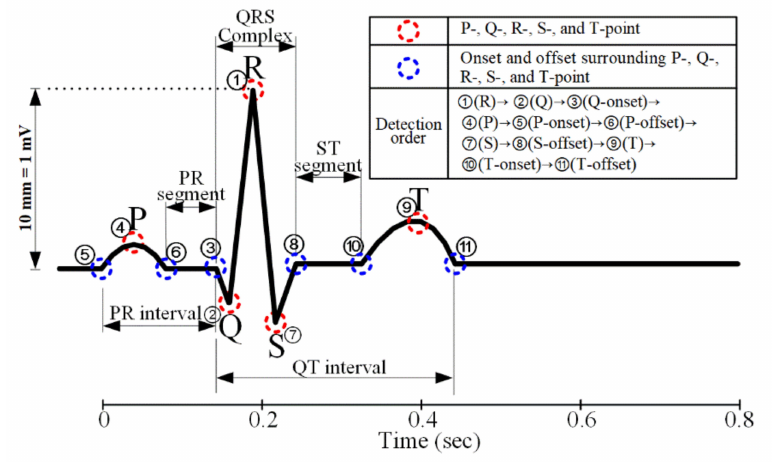
Figure 2. FPs concerning the PQRST complex and detection order.